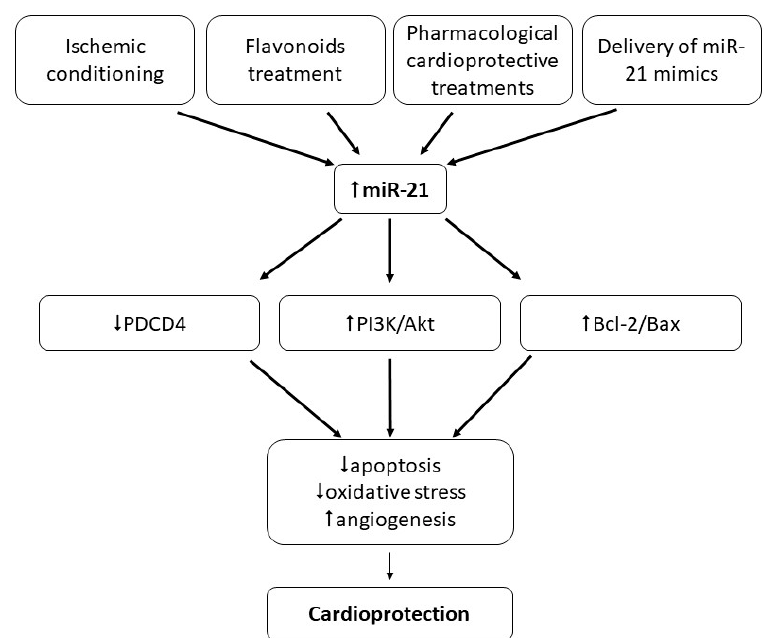
Figure 4. Role of miR-21 in cardioprotection. Up-regulation of miR-21 due to various interventions (e.g., ischemic conditioning, pharmacological and non-pharmacological, or miR-21 mimics) seems to serve cardioprotection mainly against I/R injury of the heart via inhibition of apoptosis and oxidative stress, and promoting angiogenesis.